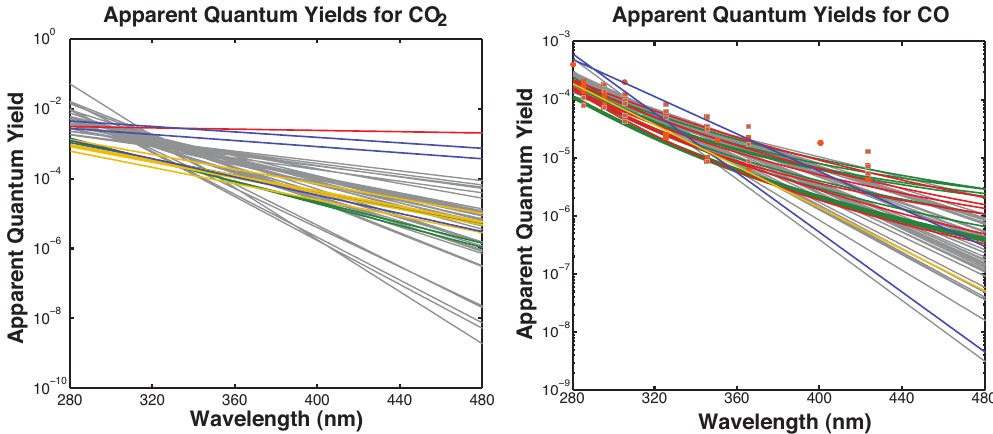
Fig. 2. Apparent quantum yield spectra for CO 2 and CO: grey background lines represent our data set; coloured lines represent literature values. CO 2 : red – Skalski (2006), yellow – Aarnos et al. (2012), green – White et al. (2010), blue – Johannessen and Miller (2001). CO: red – Zhang et al. (2006), yellow – Ziolkowski and Miller (2007), green – Xie et al. (2009), blue – Miller et al. (2002), orange squares – Stubbins et al. (2011), orange circles – Valentine and Zepp (1993).